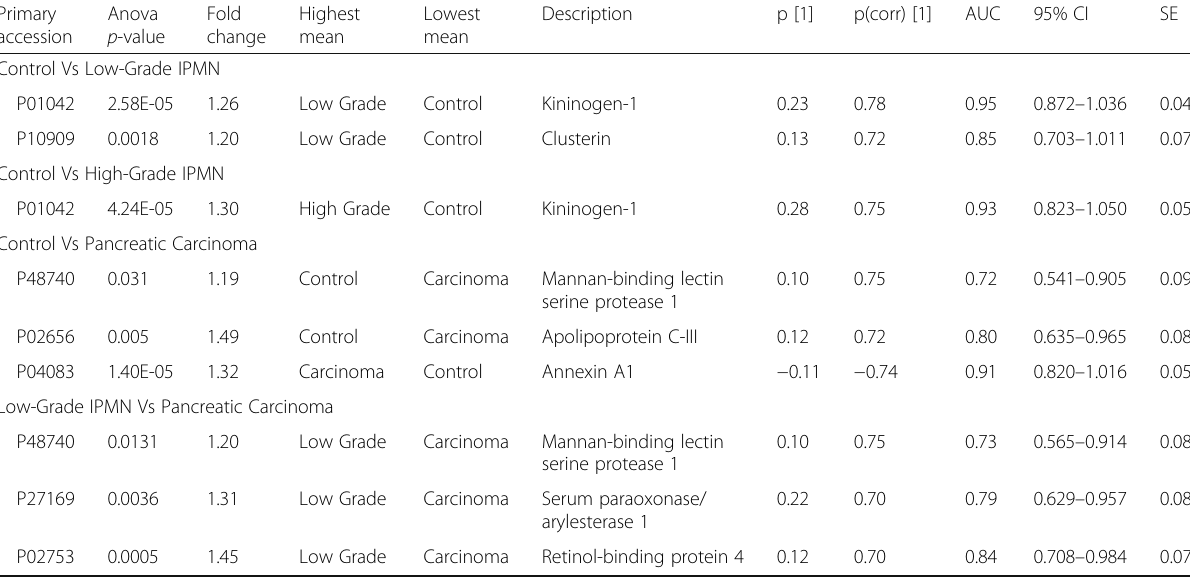
Table 2 Biomarker panels. This table presents the biomarker panels for each comparison. Accession number, ANOVA p value, fold change, S-Plot parameters values (p(Corr) [1]) and area under the curve (AUC) from ROC curve is given here. 95% confidence interval (CI) and standard error is also